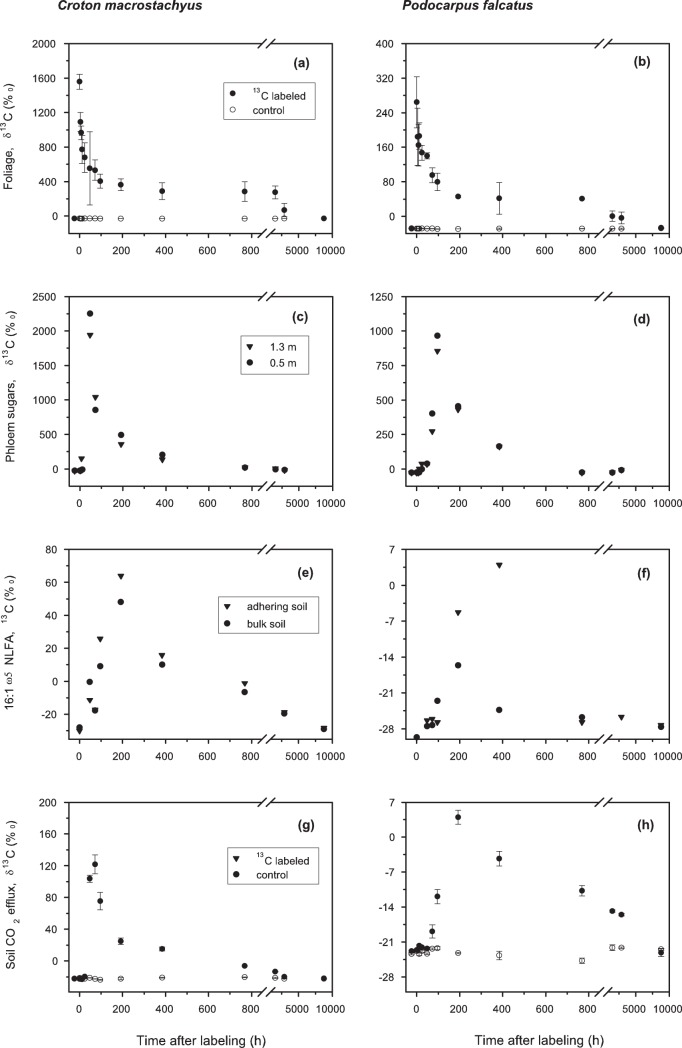
Time course of the 13C label in plant-soil compartments of Croton macrostachyus and Podocarpus falcatus during the one year chasing period.Shown are (a) leaves of C. macrostachyus, (b) leaves of P. falcatus, (c) weighed sum of soluble mono and disaccharides in tree phloem sap at 1.3 m and 0.5 m above ground of C. macrostachyus, (d) weighed sum of soluble mono and disaccharides in tree phloem sap at 1.3 m and 0.5 m above ground of P. falcatus, (e) 16∶1ω5 NLFA in adhering and bulk soil under C. macrostachyus, (f) 16∶1ω5 NLFA in adhering and bulk soil under P. falcatus, (g) soil CO2 efflux under C. macrostachyus, (h) soil CO2 efflux under P. falcatus For the sake of clarity of the figure, we omitted to show the δ13C values for the control of soluble sugars in tree phloem sap and the 16∶1ω5 NLFA in adhering and bulk soil. The former was −25.53±0.85‰ for C. macrostachyus and −25.36±0.33 ‰ for P. falcatus, and the latter was −27.7±1.4‰ for C. macrostachyus and −29.3±1.1‰ for P. falcatus. For leaves and soil CO2 efflux data are means ± standard deviation (n = 5). No replicates were taken for phloem sap extraction and soil cores for analysis of 16∶1ω5 NLFA in adhering and bulk soil to keep impact of destructive sampling to the plant-soil system to a minimum.